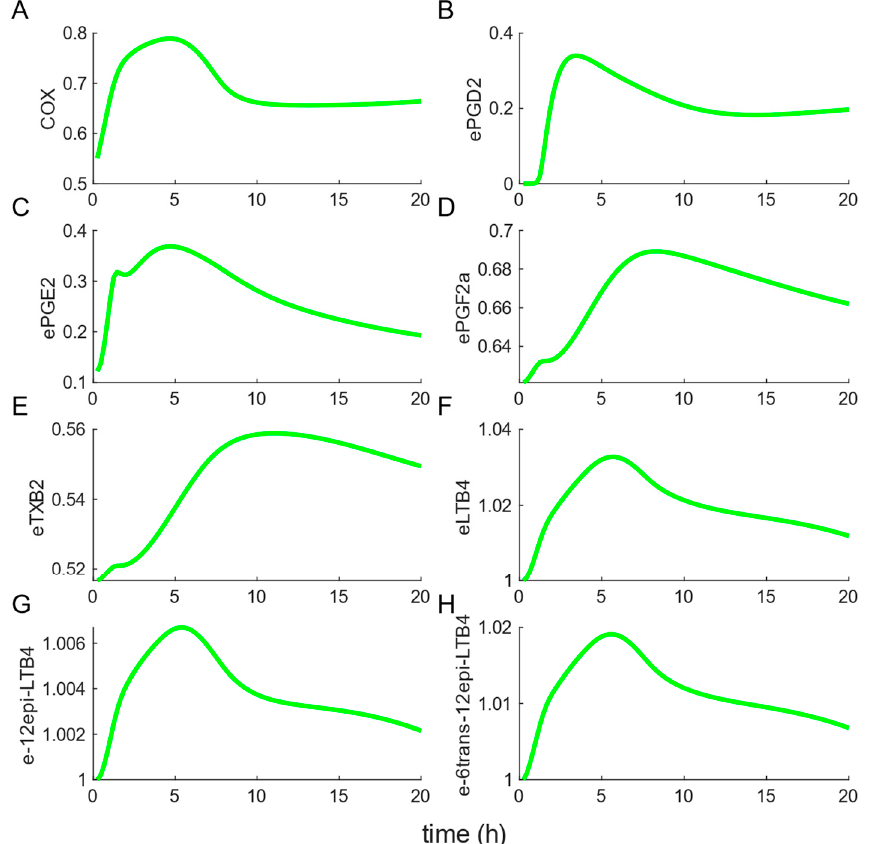
Figure 4. Scaled enzyme profiles predicted for ATP stimulated experiment. The substrate profile governs the enzyme dynamics, which follows Michaelis-Menten kinetics (second term in Equation (7)). The COX ( A ) enzyme peaks within 8 h due to a peak in its corresponding substrate AA level. Similarly, the enzymes ePGD 2 ( B ), ePGE 2 ( C ), ePGF 2a ( D ), and eTXB 2 ( E ) follow the dynamics of their substrate PGH 2 . The LOX ( F – H ) branch enzyme profiles follow the same reasoning as that of the COX branch